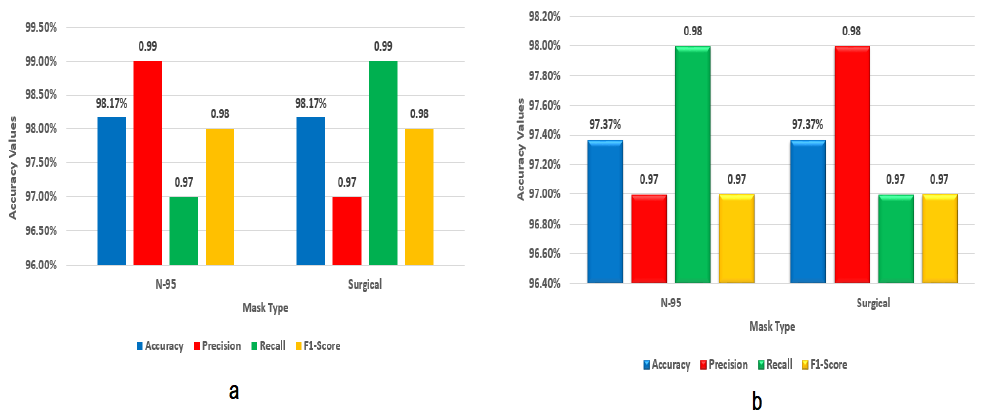
Figure 20. Statistics of two models in mask type detection and classification. The figure ( a ) shows the performance metrics using VGG-16. While the figure ( b ) represents the performance metrics for types of face masks identification and classification (N-95 or Surgical) using MobileNetV2.